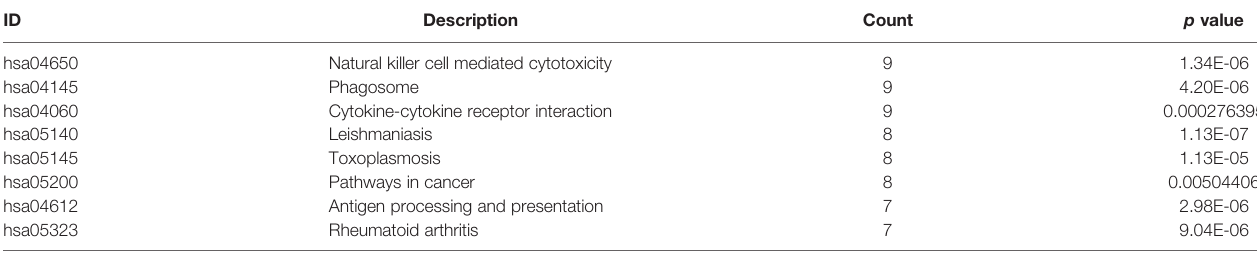
TABLE 4 | KEGG enrichment analysis results of signi fi cant gene DEGs between the case group and the control group.